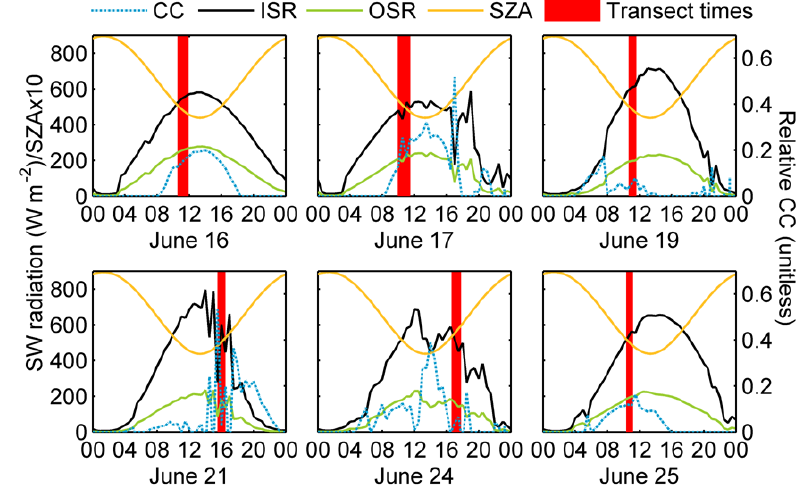
Figure B1. Radiative conditions during transect dates at the Base Met Station, including incoming solar radiation (ISR, black line), outgoing solar radiation (OSR, green line; left y axis), modeled relative cloud cover (CC, blue stippled line; right y axis), and solar zenith angles (SZA, yellow line right axis). Red shaded regions show α ASD data collection times.